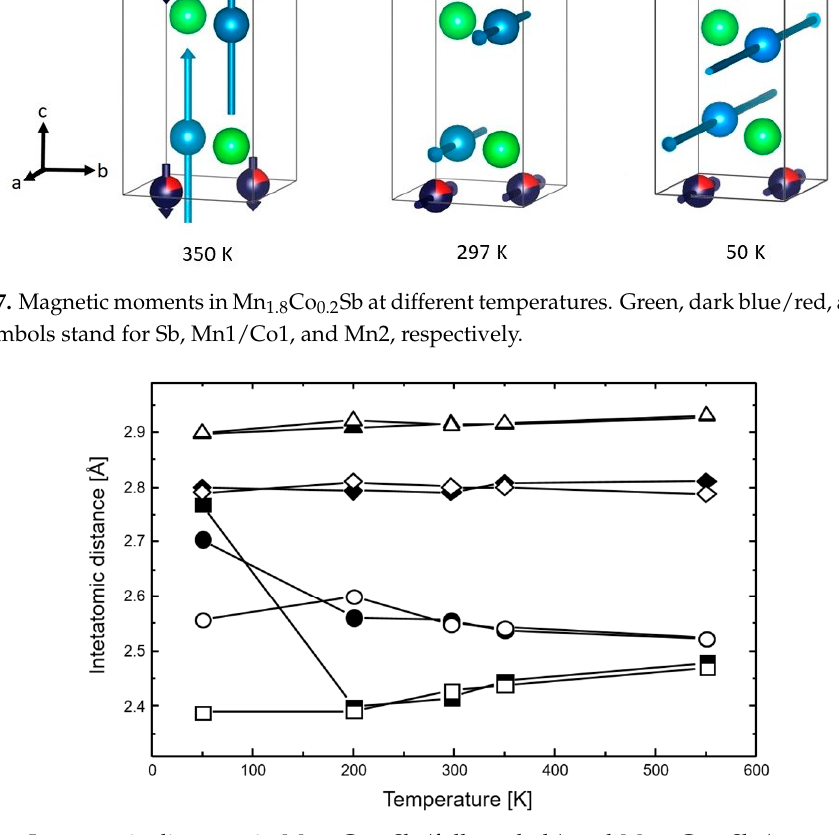
Figure 8. Interatomic distances in Mn 1.8 Co 0.2 Sb (full symbols) and Mn 1.9 Co 0.1 Sb (open symbols): Mn2–Sb distance (triangles); Mn2–Sb’ distance (diamonds); Mn1/Co1–Sb distance (circles); Mn1/Co1–Mn2 distance (squares). The estimated standard deviations are smaller than the symbols. Lines are guides for the eye.